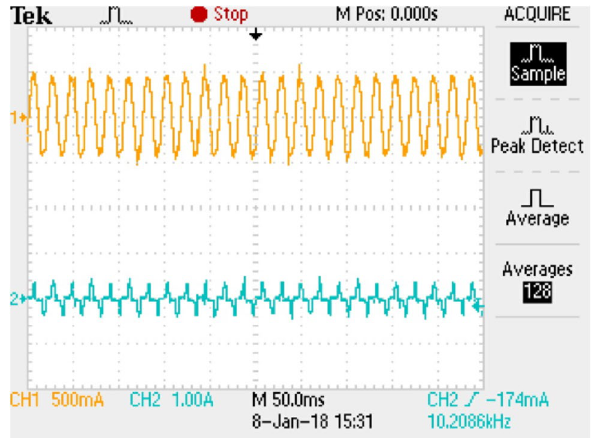
Fig. 14 Variation pattern of load current, dump load current and generator current with power output